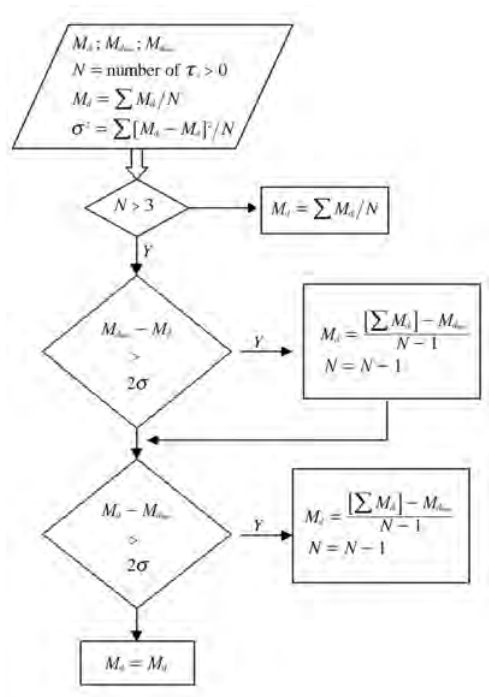
Fig. 3. Flowchart of the algorithm that attributes the M d value to a regional event. This quantity is cal- culated as the arithmetic average eventually remo- ving the maximum and (/or) the minimum, if they are «very distant» from the